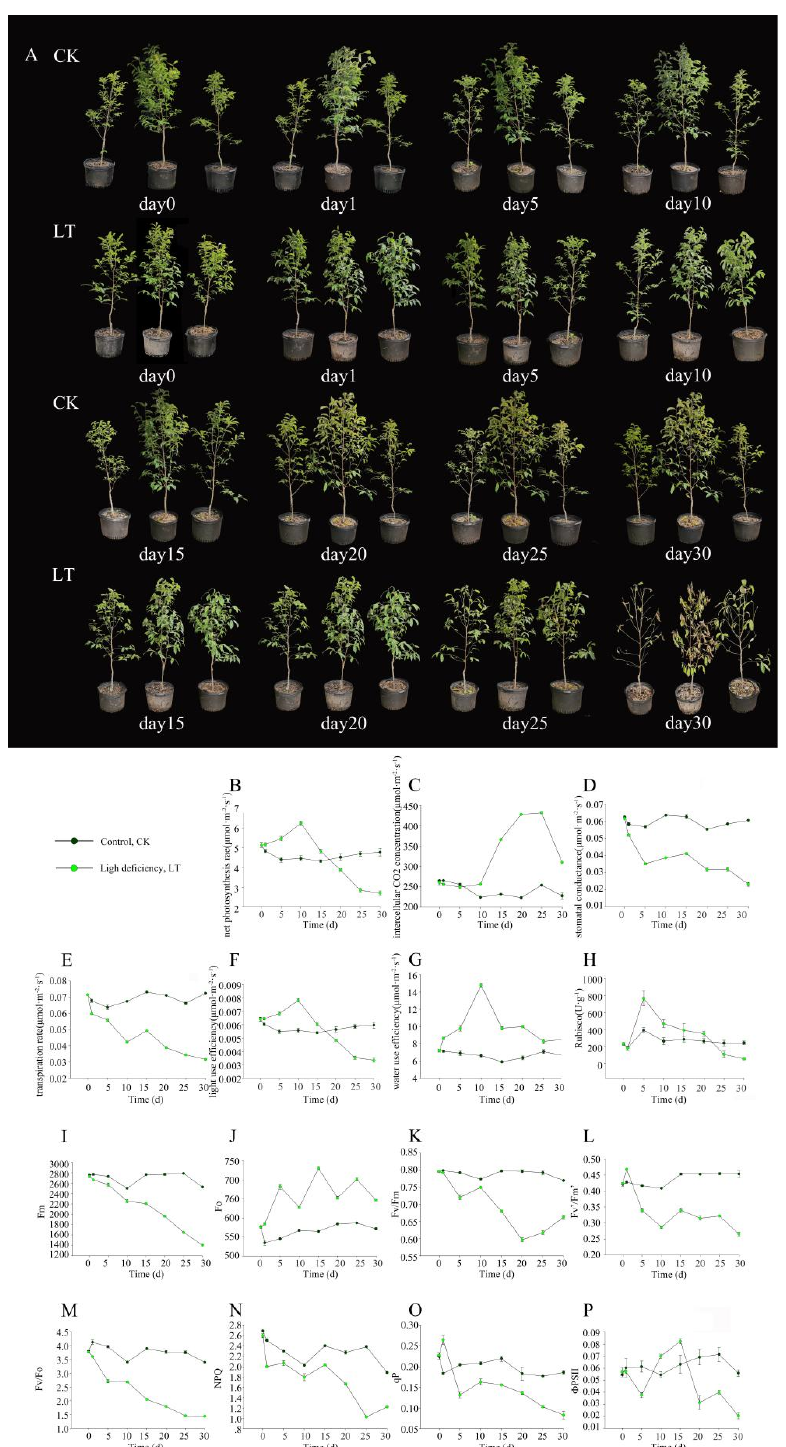
Figure 1. Phenotypic and physiological changes of M. sinostellata seedlings under light deficiency. ( A ) Phenotypic shifting of M. sinostellata during experiment. ( B ) Net photosynthesis rate, Pn . ( C ) Intercellular CO 2 concentration, Ci . ( D ) Stomatal conductance, Gs . ( E ) Transpiration rate, Tr . ( F ) Light use efficiency, LUE . ( G ) Water use efficiency, WUE . ( H ) Rubiso activity. ( I ) Maximum Chl fluorescence yield obtained with dark-adapted leaf, Fm. ( J ) Minimum Chl fluorescence yield obtained with dark-adapted leaf, Fo. ( K ) Maximal photochemical efficiency, Fv/Fm. ( L ) Excitation energy cap- ture efficiency of PSII, Fv’/Fm’. ( M ) Activity of PSII reaction centers, Fv/Fo. ( N ) Non-photochemical quenching, NPQ. ( O ) Photochemical quenching, qP. ( P ) Yield of PSII photochemistry, Φ